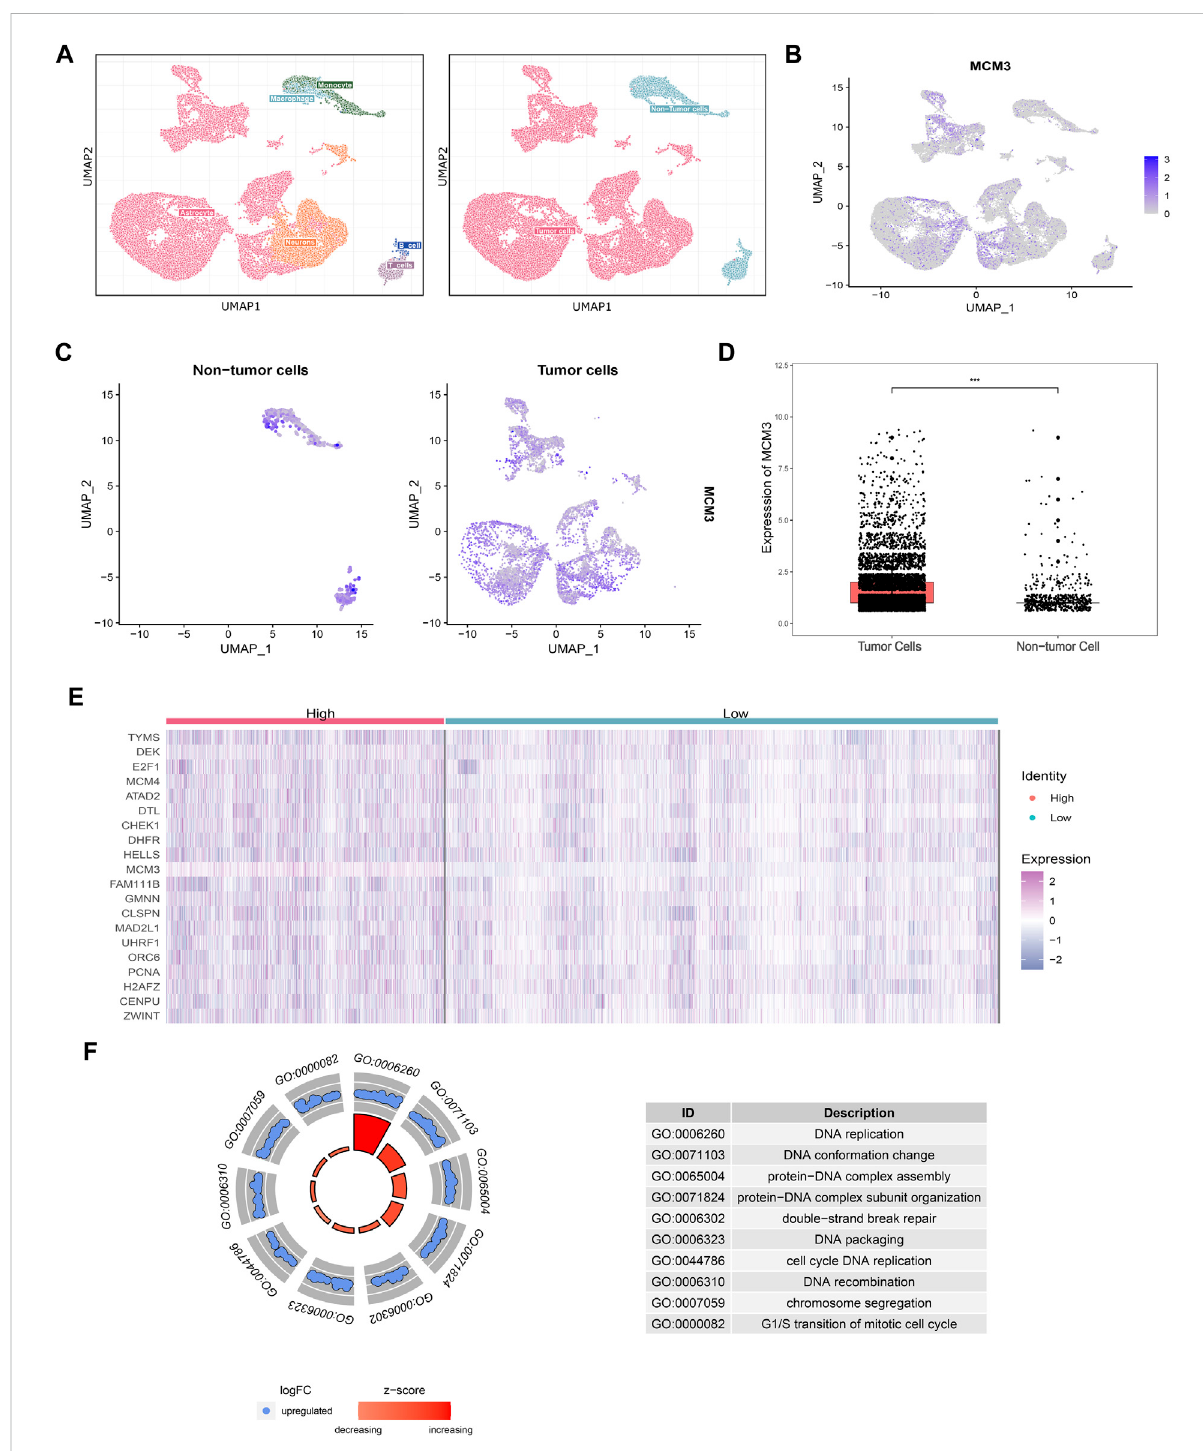
FIGURE 2 Cell annotations according to SingleR and cell classi fi cations of malignant and non-malignant Cell annotations according to SingleR and cell classi fi cationsofmalignantandnon-malignantcells (A) .HeterogeneityofMCM3expressionindifferentclusters (B) .HeterogeneityofMCM3express ionintumorandnon-tumorcells (C) .MCM3over-expression intumorcellscomparedtonon-tumorcells (D) .Top20DEGs (E) andthetop10GO (F) annotations of 159 DEGs between the two groups of malignant cells (high and low MCM3